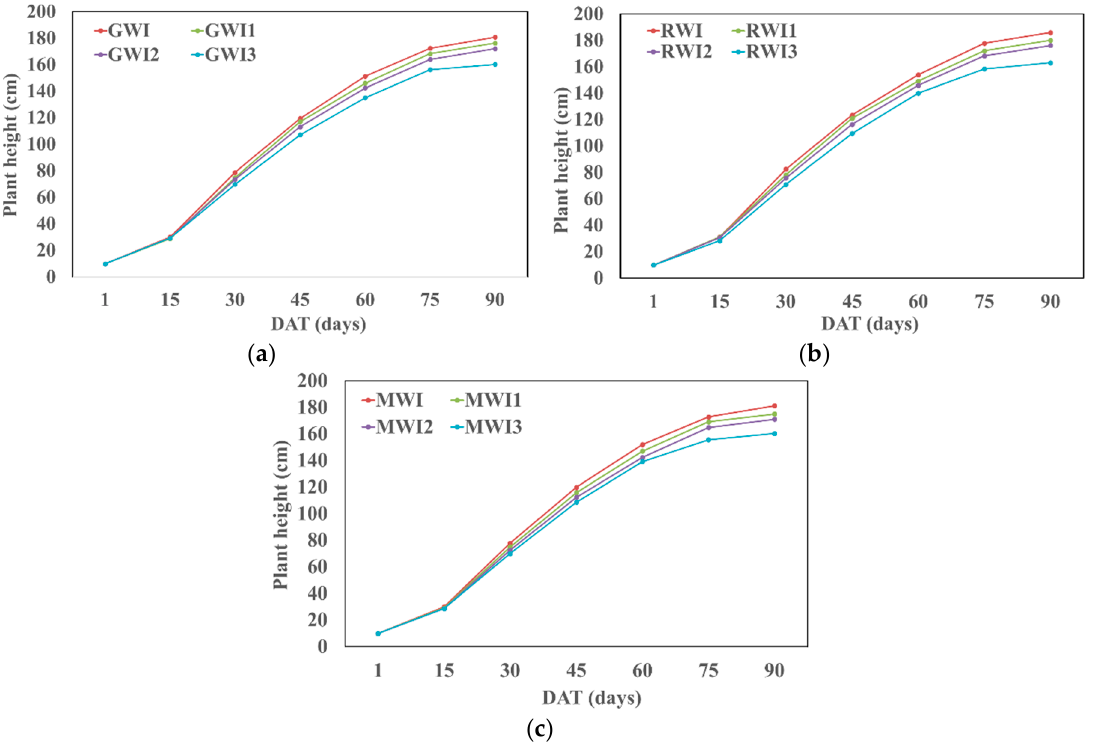
Figure 3. Plant height variation under different DI levels of GW ( a ), RW ( b ) and MW ( c ) in